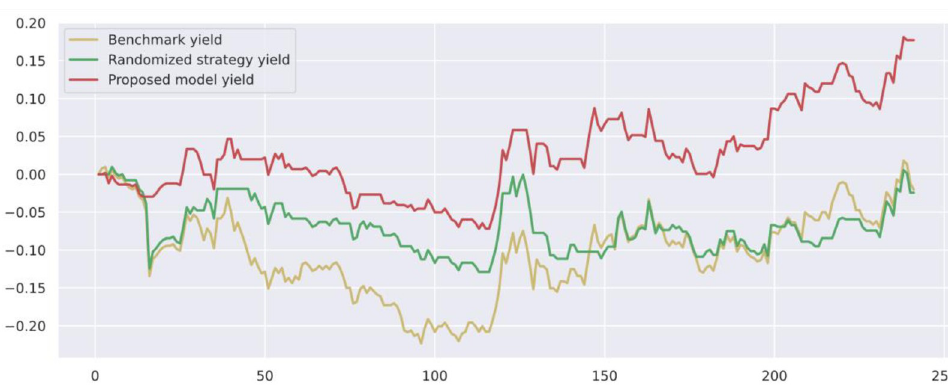
Fig 15. China nuclear power stock strategy returns.